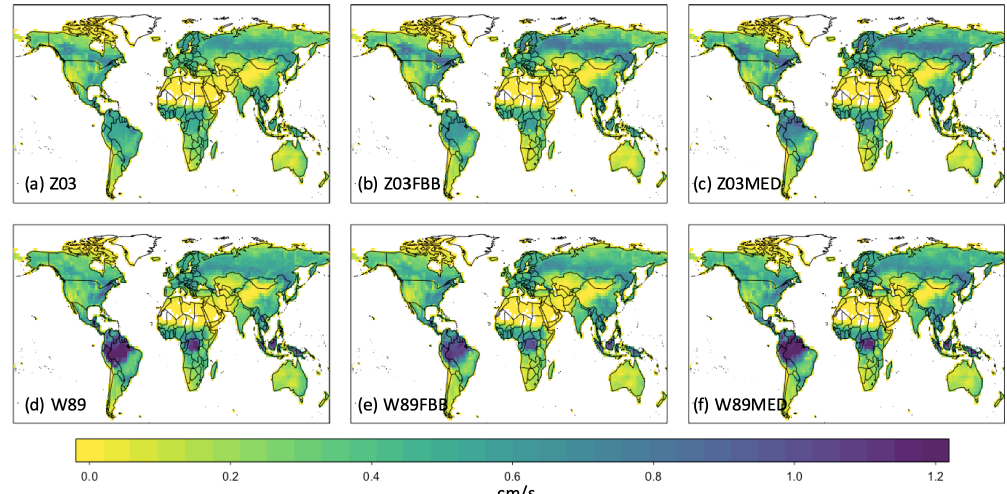
Figure 9. The 2010–2014 July average daytime v d under 390ppm CO 2 level simulated with the six dry deposition schemes: (a) Z03,